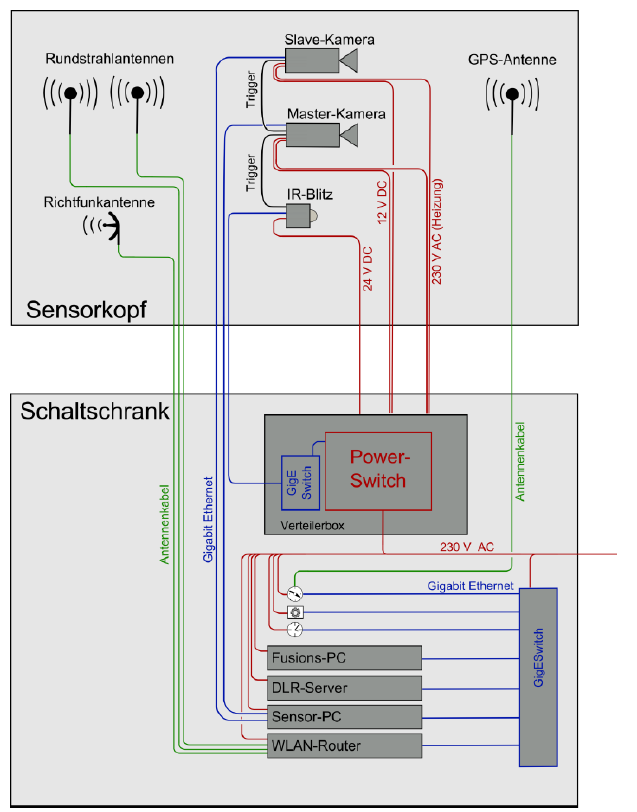
Figure 1: Technical architecture of a sensor pole